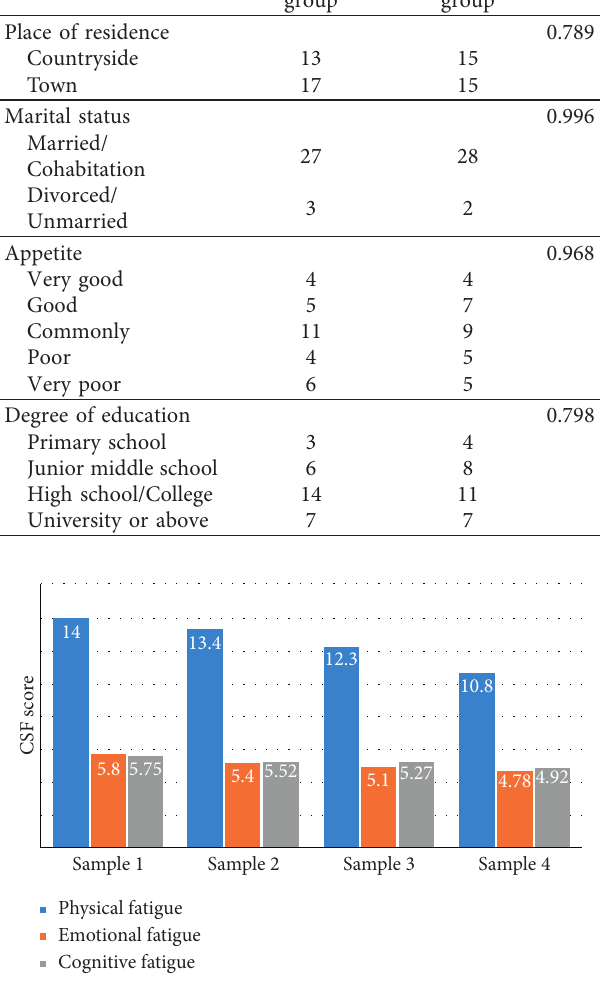
Figure 1: Changes of CFS score in the intervention group after football